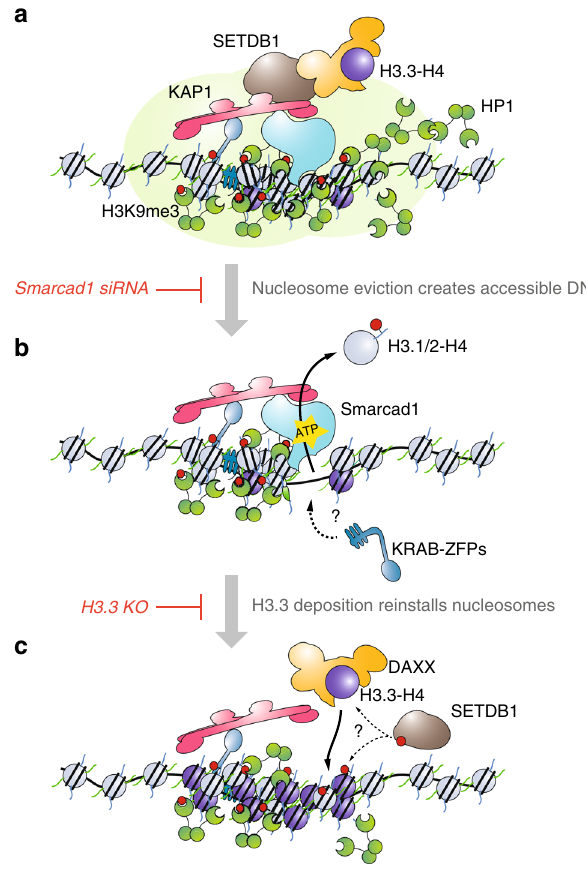
Fig. 7 Molecular mechanism underlying dynamic